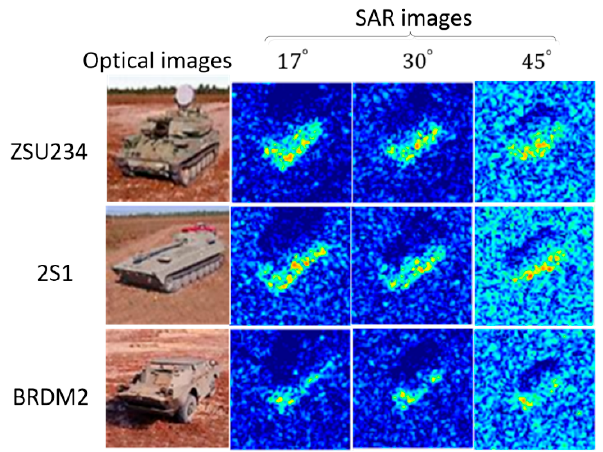
Figure 7. Illustration of target images at different depression angles. All targets have an azimuth angle of 45°.